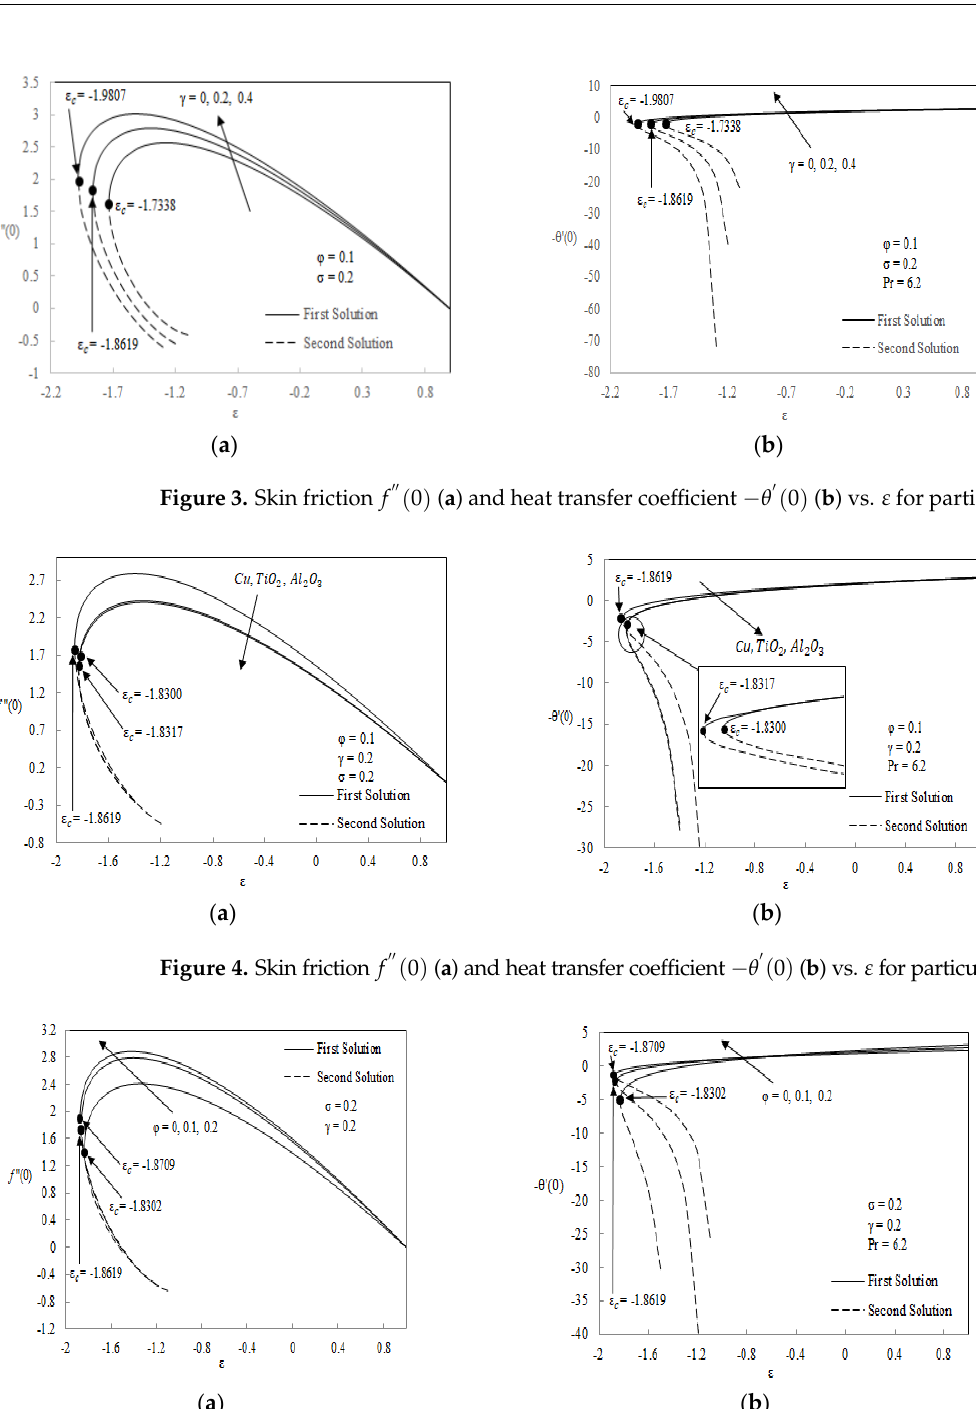
Figure 2. Skin friction 𝑓 (cid:4593)(cid:4593) (cid:4666) 0 (cid:4667) ( a ) and heat transfer coefficient (cid:3398)𝜃 (cid:4593) (cid:4666) 0 (cid:4667) ( b ) vs. 𝜀 for particular values of 𝜎 .